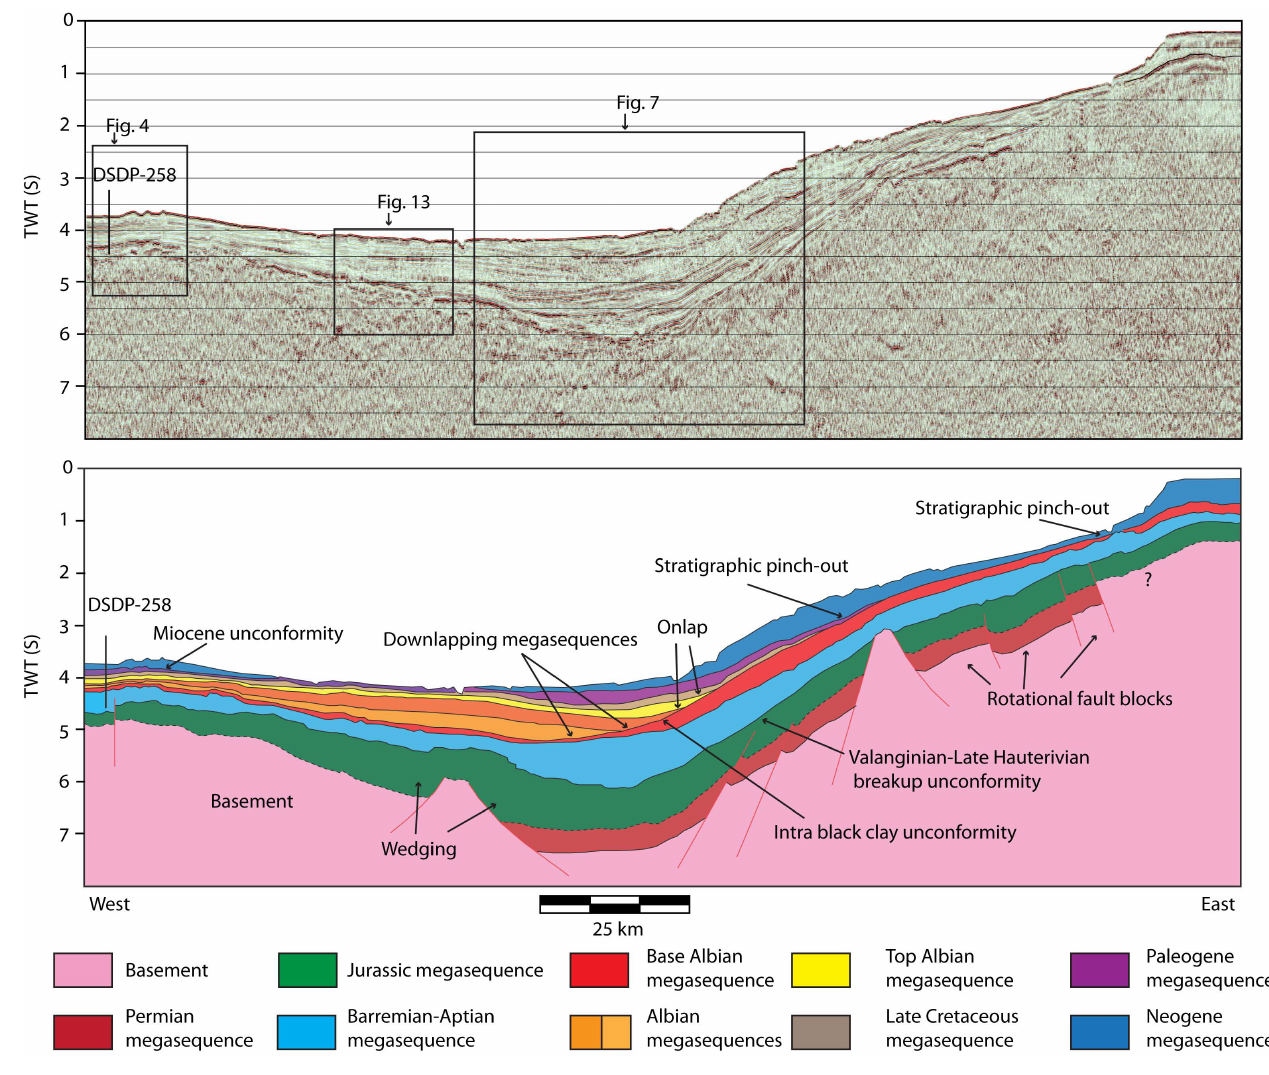
Fig. 5. (A) Uninterpreted dip section through the Mentelle Basin and (B) interpreted section of (A) depicting the architecture and char- acteristic of seismic megasequences, which constitute the Mentelle Basin fill. Basement structure is also displayed. A series of major unconformities are located within the centre of the Mentelle Basin upon which numerous megasequences onlap and pinchout.